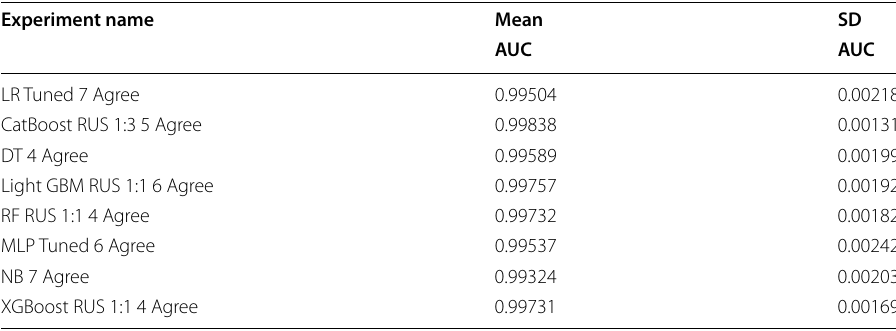
Table 5 Maximum AUC by classifier for the information theft attack type; mean and standard deviations of AUC, (10 iterations of 5-fold cross-validation)